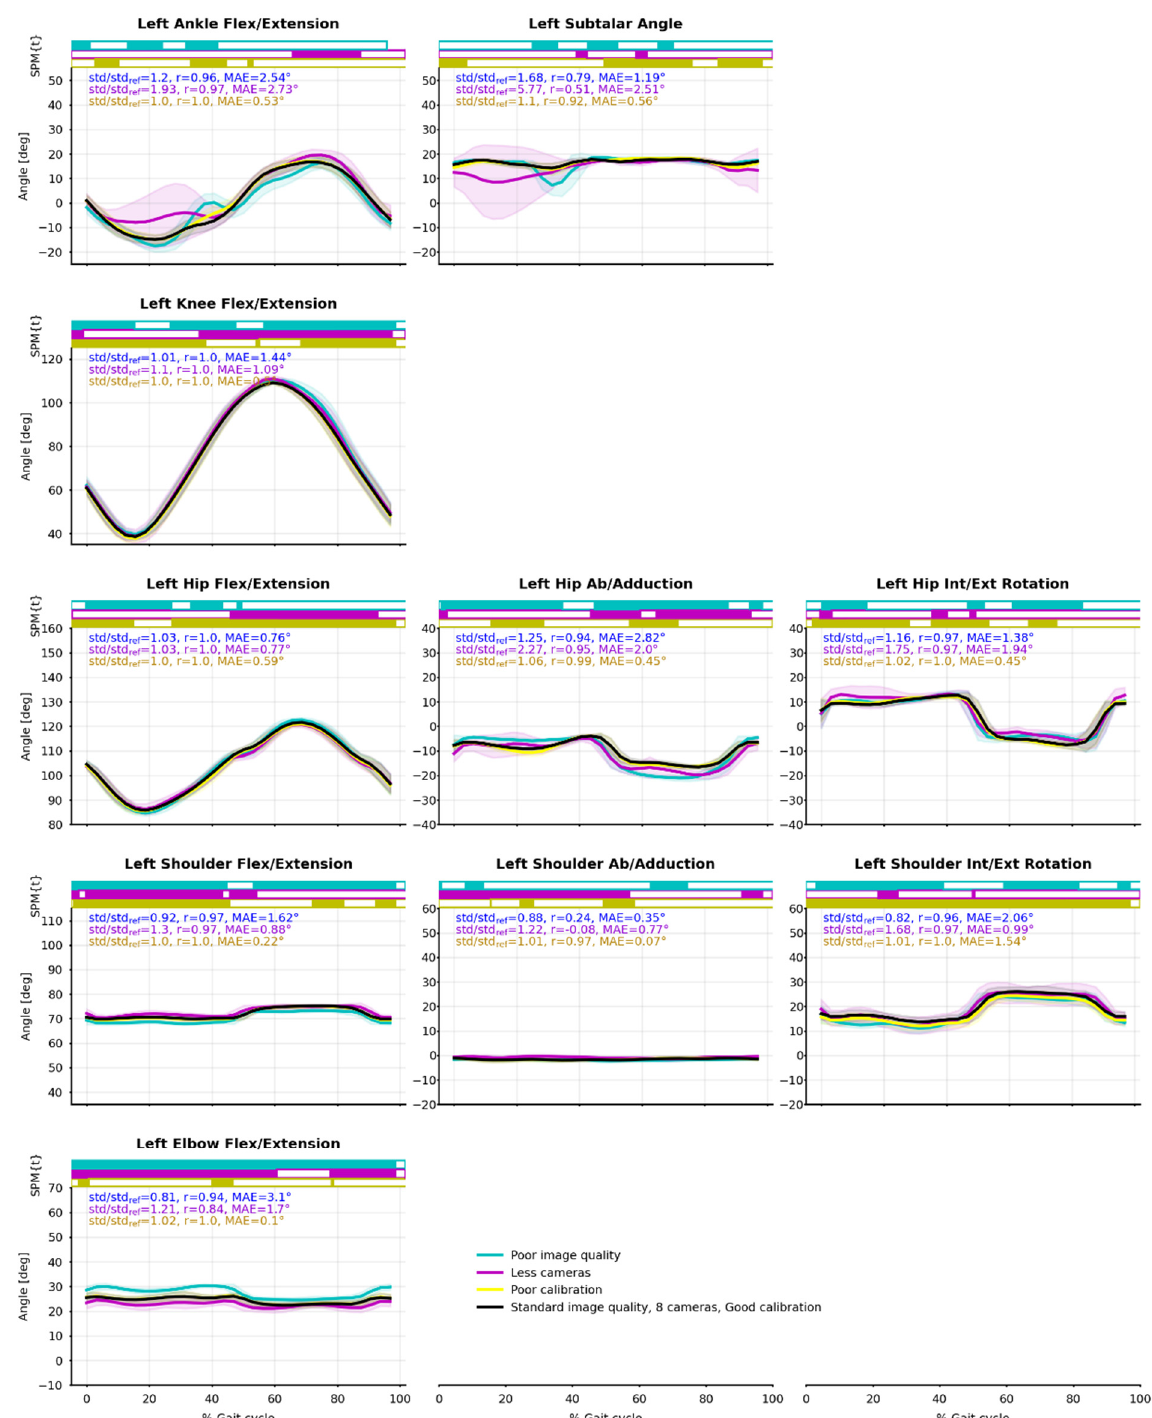
Figure A2. Joint angle means (solid line) and standard deviations (shaded area) from the 15 captured cycles of cycling. Reference condition (Ref) is black; degraded image quality (Im) is blue; four cameras instead of eight (4c) is purple; degraded calibration (Cal) is yellow. Pearson’s correlation coefficient (r) and mean absolute error (MAE) between Ref and Im, 4c, Cal were calculated. Paired t-tests along time were computed by SPM-1D and are represented as bar plots above the curves: a color rectangle means that there was a cluster of statistically significant differences ( α = 0.05) at that moment.